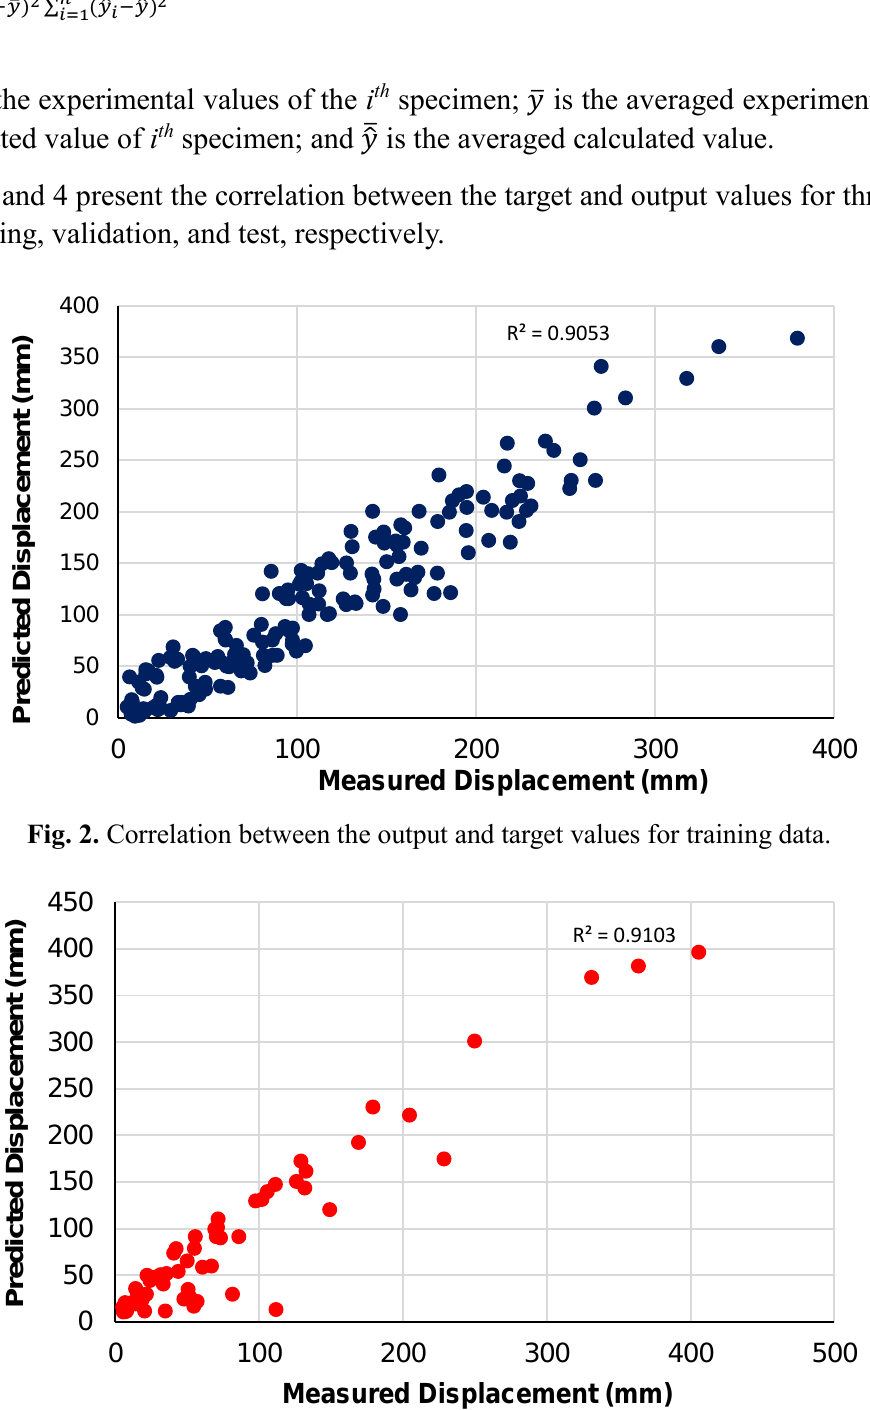
Fig. 3. Correlation between output and target values for Check data.